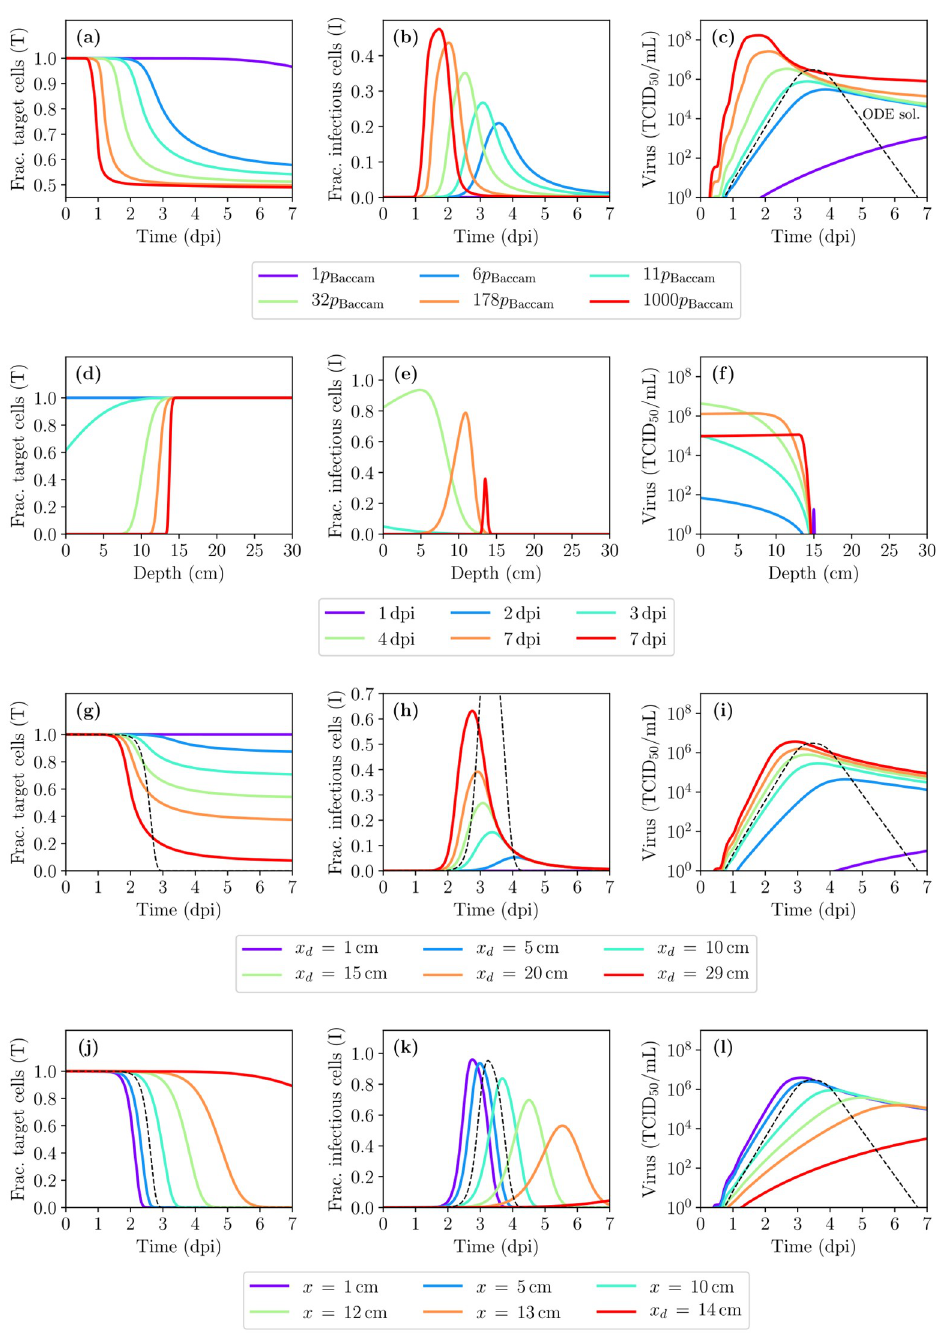
Fig 3. IAV infection kinetics in the presence of diffusion and advection. (a,b,c) Time course (averaged over space) of the infection for the fraction of cells in the (a) target/uninfected or (b) infectious state, and (c) the infectious virus concentration, obtained using the ODE MM (dashed) or the spatial MM (solid), as the rate of virus production, p , is varied. (d,e,f) Localized fraction of cells in the (d) target or (e) infectious state and (f) the infectious virus concentration as a function of depth within the HRT shown at specific days post-infection (dpi). (g,h,i) Same as (a,b,c) but varying the depth of deposition of the initial virus inoculum ( x d ). (j,k,l) Similar to (a,b,c) but rather than being averaged over space, the infection time course is shown at specific, spatially localized depths ( x ). Unless otherwise noted, p = 11 × p Baccam and x d = 15